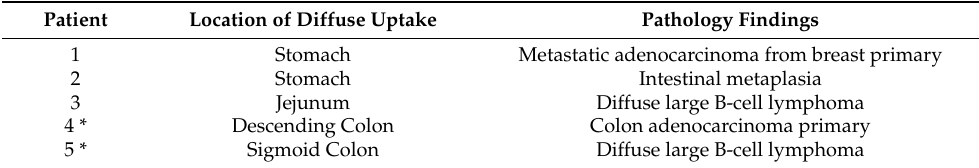
Table 4. Characteristics of the cancerous or pre-cancerous lesions in patients with diffuse FDG uptake.